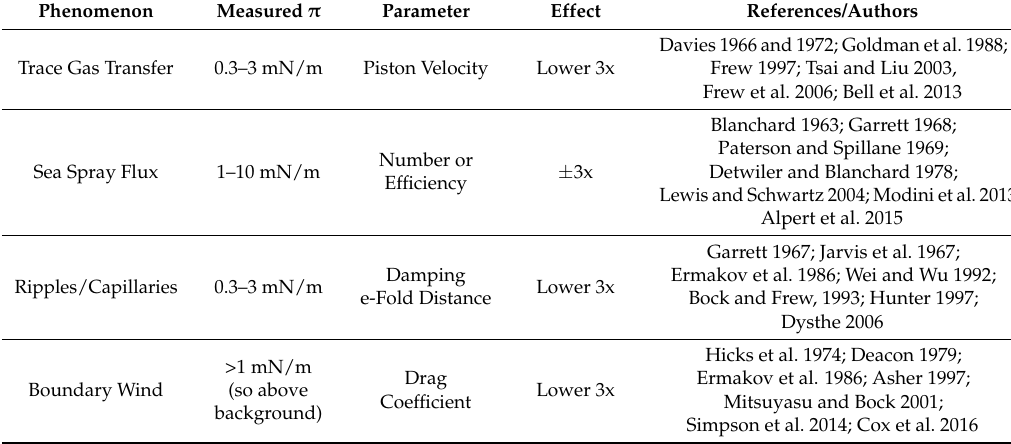
Table 1. A sampling of global ocean (2D) surface pressure ranges along with documented influence on several parameters related to sea-air flux types. All processes are dominated by the biomacromolecular surfactant effects cited here. While reduction mechanisms trace to the elastic modulus, surface tension is more often reported and the two quantities are interconnected. Uncertainties in the “effect” column constitute another factor of approximately three above the π range. As explained in the text, for the spray flux case the sign of the effect has not been